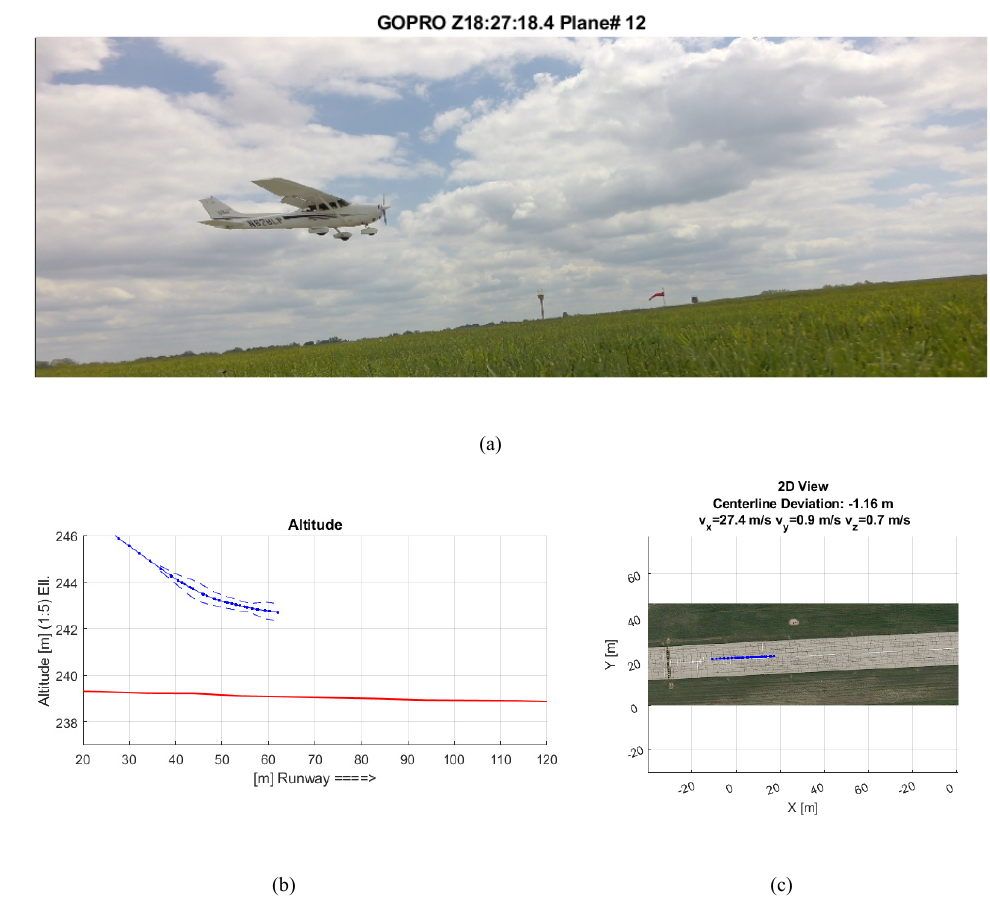
Figure 17. Aircraft tracking: ( a ) current video frame, ( b ) altitude profile with blue dashed line showing the error envelope in cm, red line is the runway surface, and ( c ) 2D